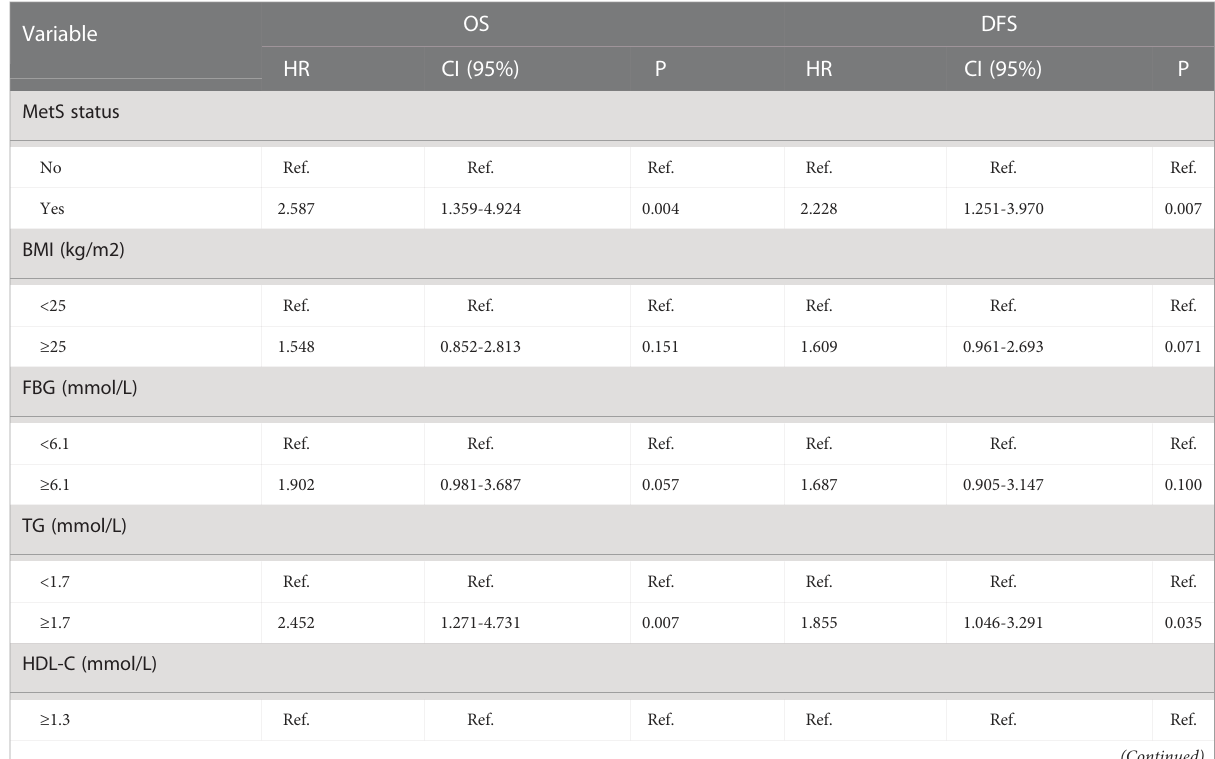
TABLE 6 Multivariate analysis of hazards ratios for OS and DFS by MetS